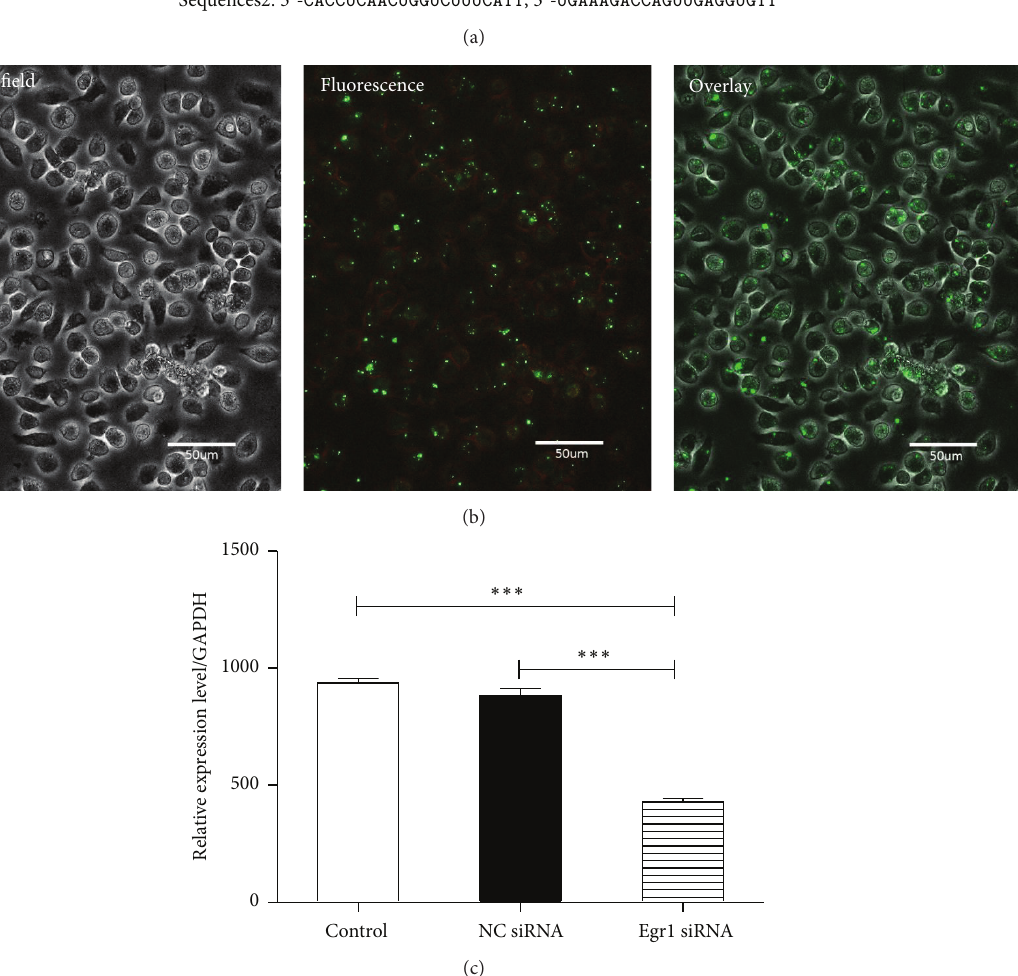
Figure 8: The transfection of EPCs by Egr1-siRNA. (a) The sequences for mouse Egr1-siRNAs. (b) After 6h of incubation at 37 ∘ C with siRNA, transfection efficiencies can be achieved up to 90%. (c) After more 48 h of incubation at 37 ∘ C, EPCs transfected with Egr1-siRNA showed a decreased expression level of Egr-1, and the inhibition efficiencies can be up to 60%. All assays were triplicated and demonstrated similar results. Data are presented in mean ± SD format. ∗∗∗ 𝑃 < 0.001 versus control